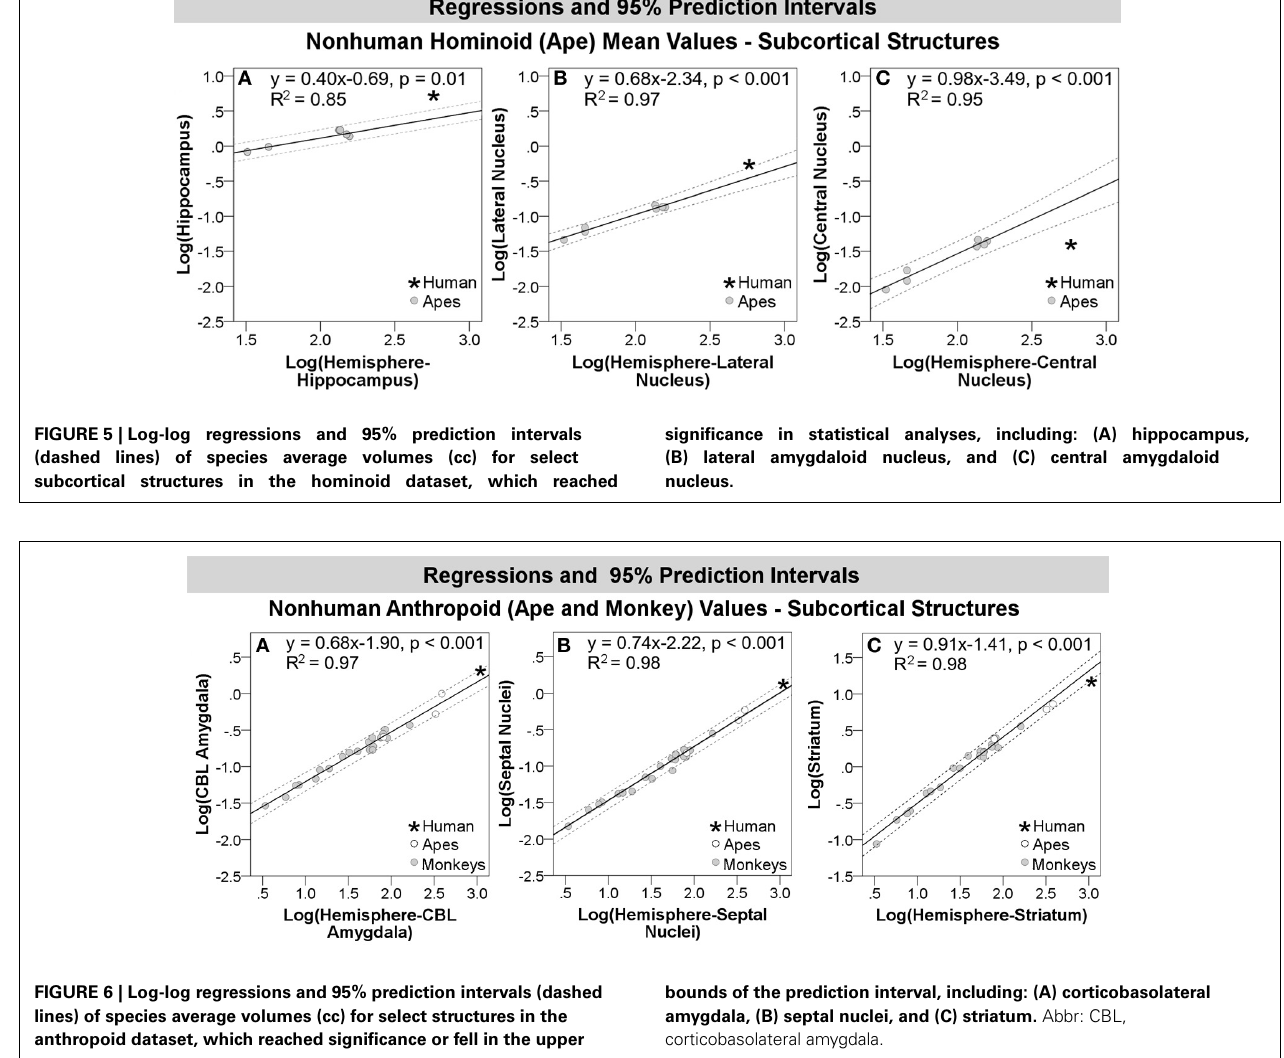
bounds of the prediction interval, including: (A) corticobasolateral amygdala, (B) septal nuclei, and (C) striatum. Abbr: CBL, corticobasolateral amygdala.